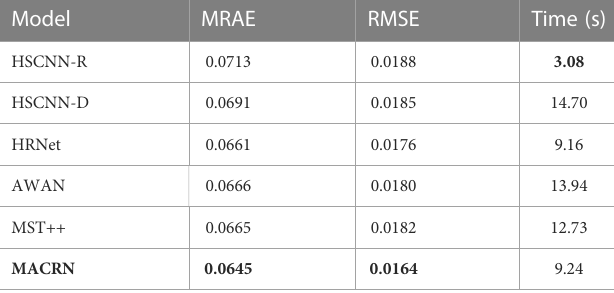
TABLE 2 Comparison of reconstruction results of various models run with the Realworld